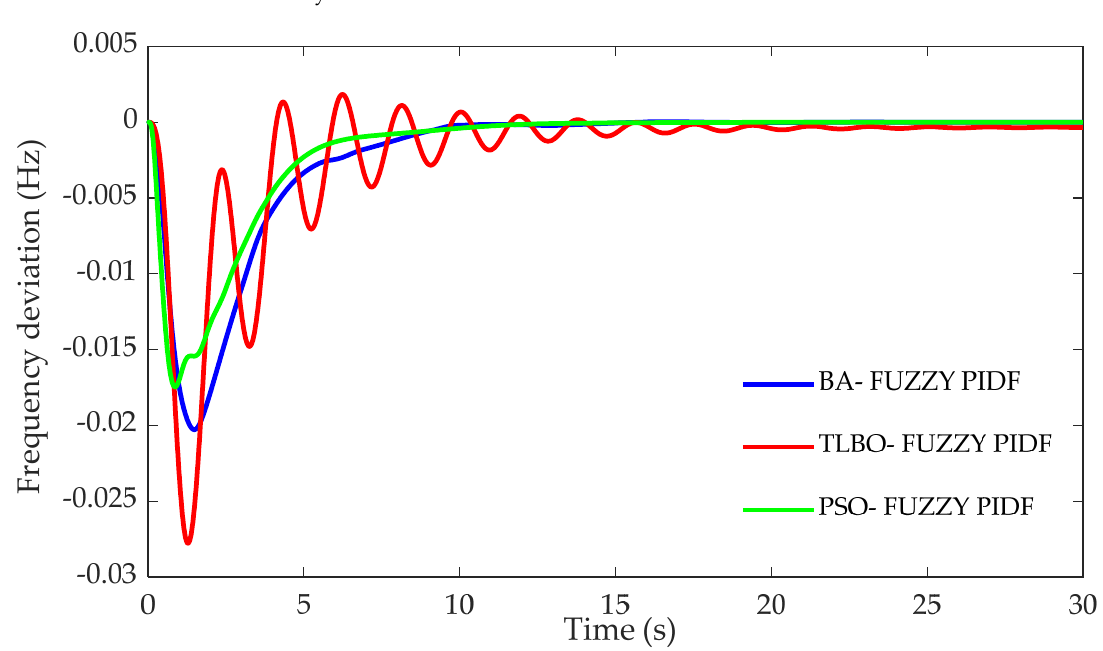
Figure 9. Frequency deviation in area one ( ∆ F 1 in Hz) under parametric uncertainties of the testbed system.